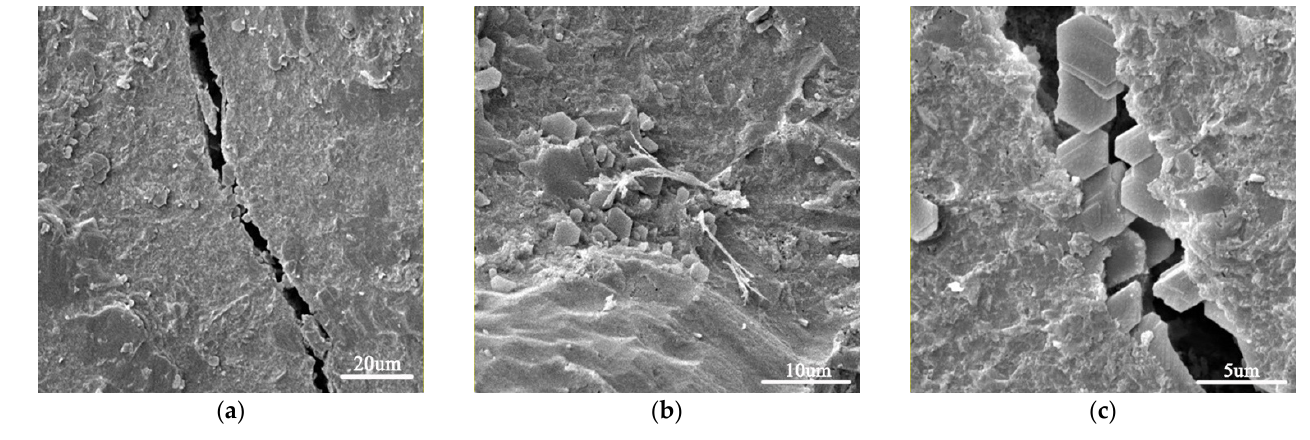
Figure 3. SEM images of GO-incorporated cement mortar MG4 ( a – c ) at different scales